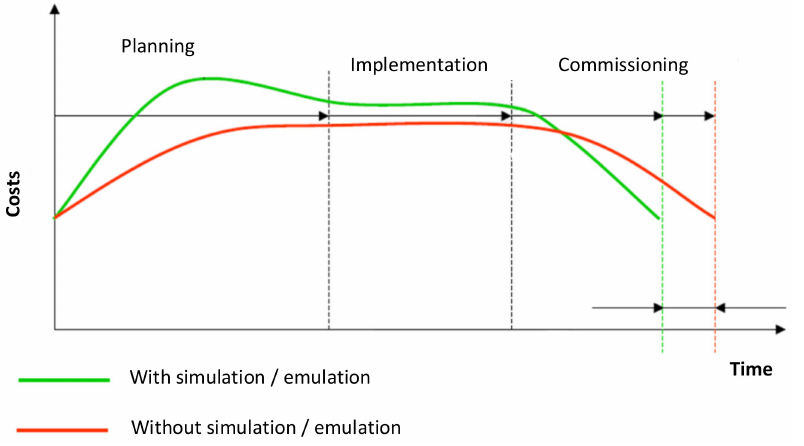
Figure 14. Cost during the project with and without the use of simulation and emulation. Table 2. Estimation of the economic complexity of deploying a system for verification of AGV routes using computer